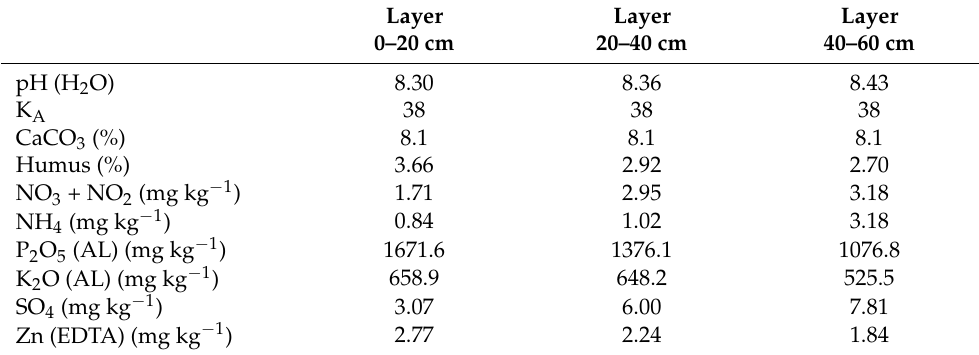
Table 4. Soil analysis results of the experiment area (2021, Debrecen), first published by Kutasy et al.